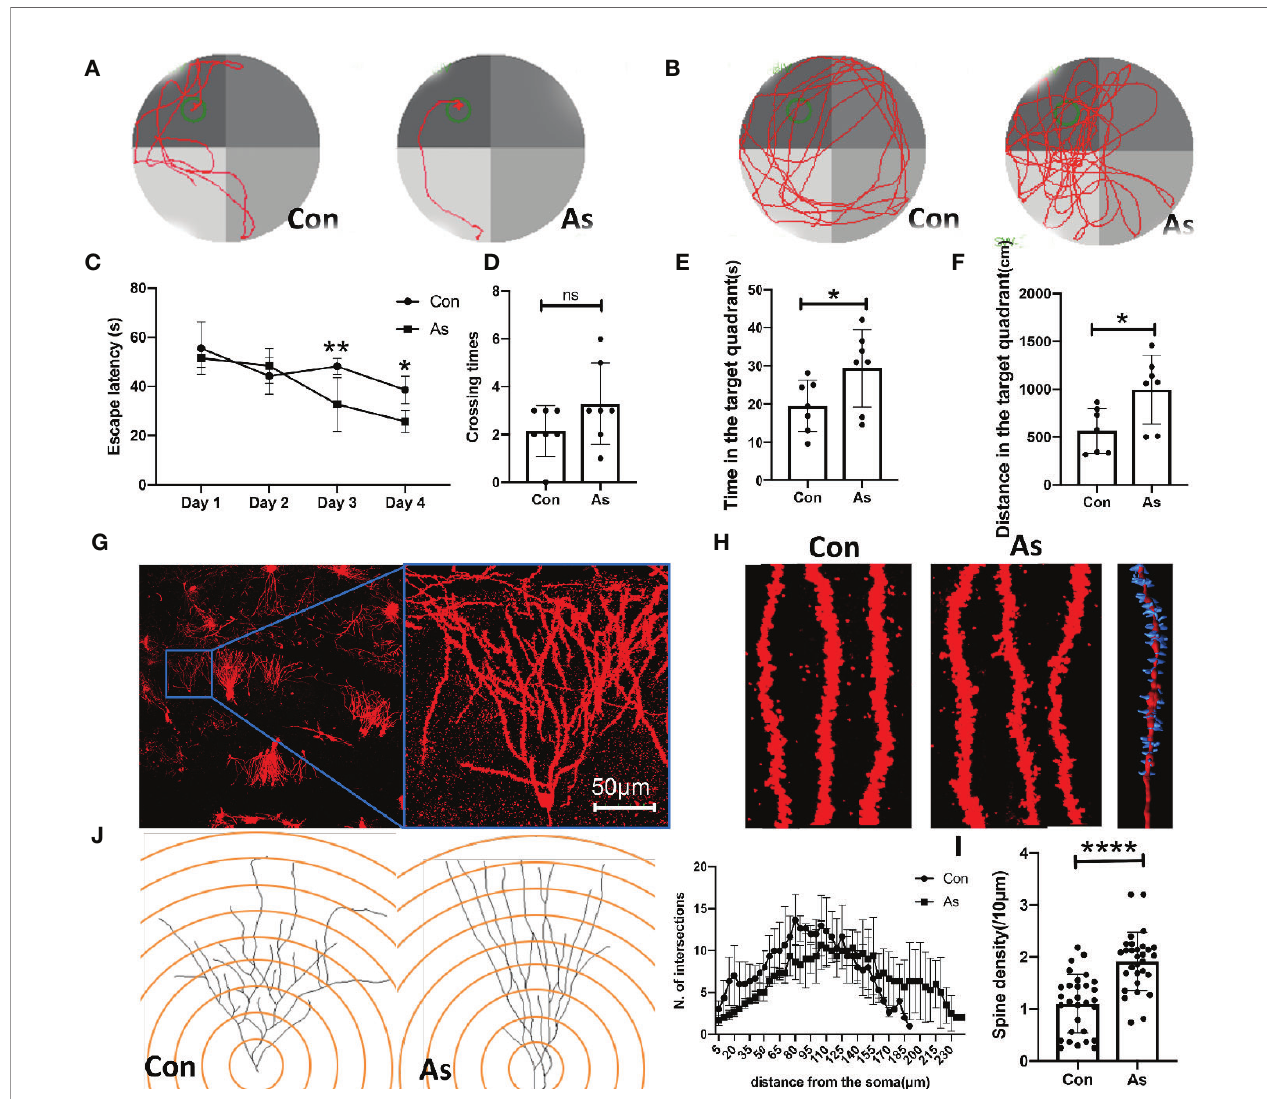
FIGURE 1 | As IV improves spatial learning and memory abilities and enhances neuroplasticity in the hippocampus after stroke. (A, B) Representative graphs of swimming tracks on the fourth day for training and the fi fth day for test in MWM. (C) On the third and fourth days, the mice in the As group spent less time fi nding the platform than those in the control group after training. n = 7. Multiple-t tests. (D) The numbers of crossings increased slightly on the fi fth day in the mice treated with As IV. (E, F) On the fi fth day, the mice in the As group spent more time and distance in the target quadrant. n = 7, *p < 0.05, **p < 0.01. (G, H) Representative dendrites and their spines in hippocampus after stroke in Golgi staining. The right graph showed the three-dimensional reconstruction for a spine in part of one dendrite created with Imaris software. (J) Sholl analysis was used to evaluate neuron repair in the ischemic hippocampus between the control and As groups. Notably, more neurons with normal morphology and longer distal apical branches were found in the As groups. n = 4. Multiple-t tests. (I) The density of spines per 10 m m in apical dendrites was increased in the As group according to Imaris analysis. n = 4, ****p < 0.0001. Con, control; As, Astragaloside IV; MWM, Morris Water